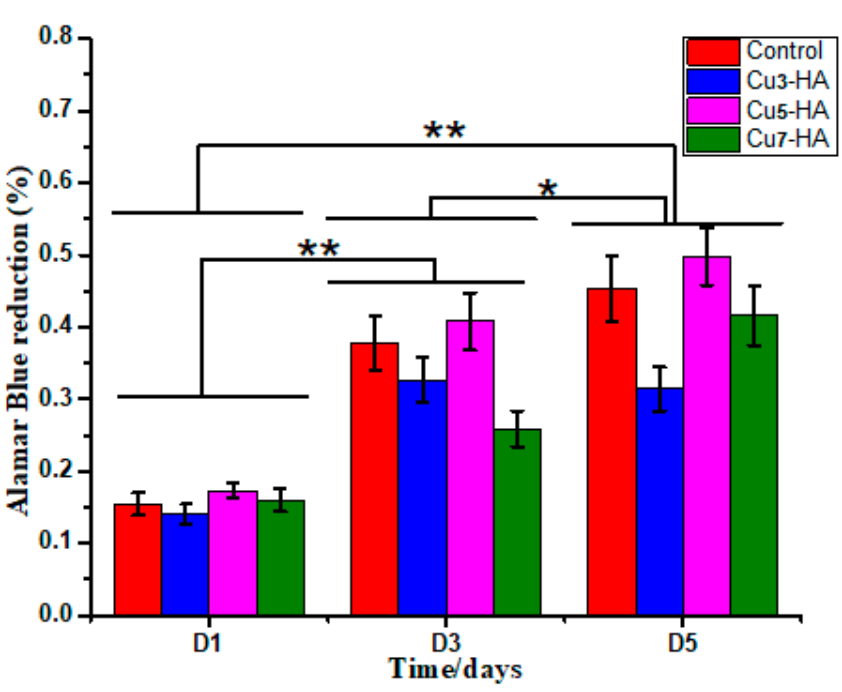
Figure 8. The bar chart illustrated EC viability during cell culture. * and ** denote significant differences between groups at the p < 0.1 and p < 0.05 levels, respectively.